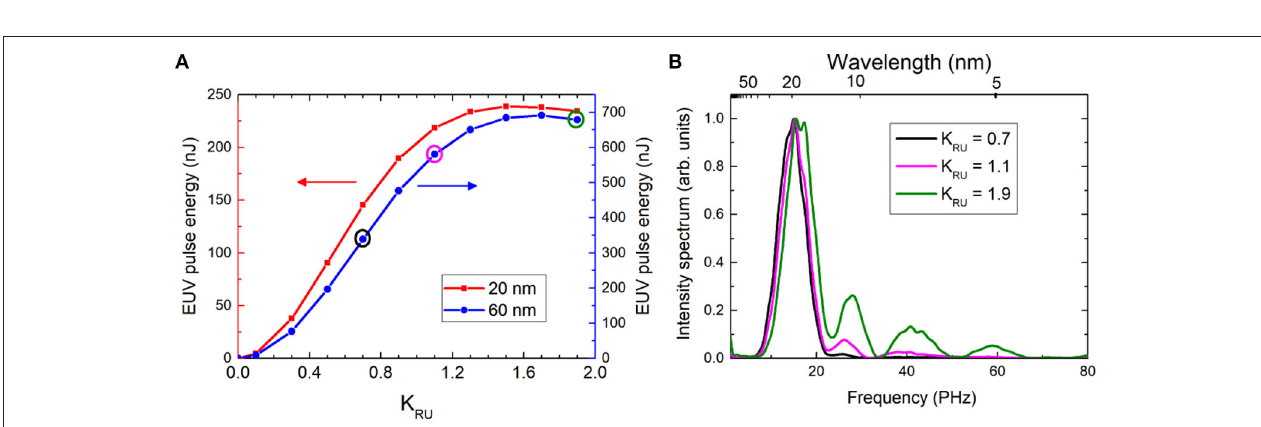
FIGURE 4 | (A) Dependence of the EUV pulse energy on the radiation wavelength λ r for 100pC and 1000pC cases for K = 0.5 and K = 0.8. ( B) shows the distribution of macroparticles along the z axis at the entrance (black curve) and the end of the RU for λ r = 20nm and 200nm (red and blue curves).